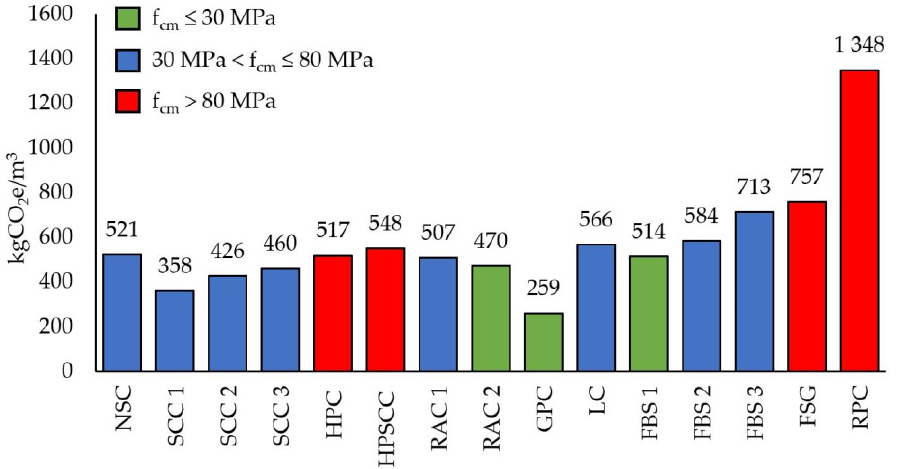
Figure 9. Carbon footprint over the life cycle of concrete per 1 m 3 of concrete mix.